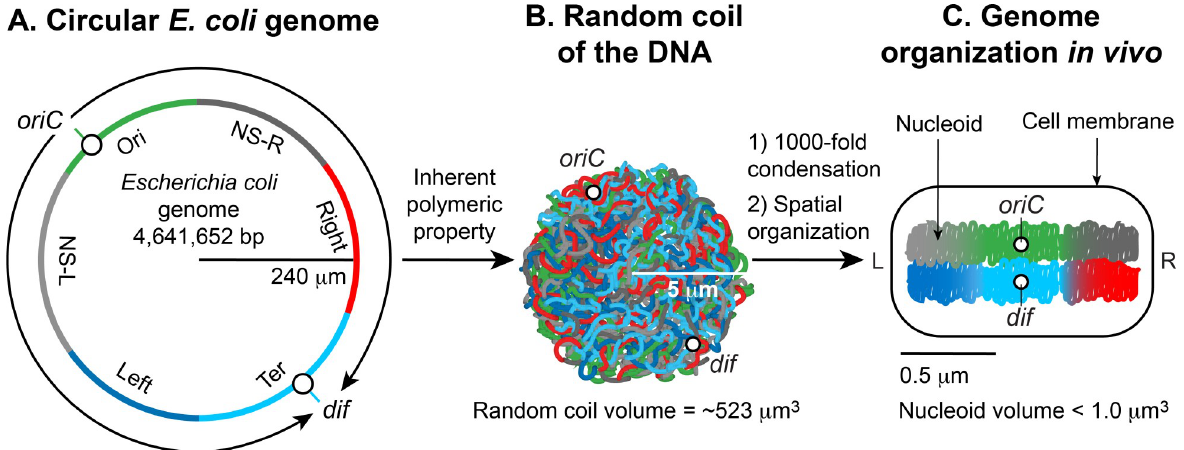
Fig 1. Formation of the Escherichia coli nucleoid. A. An illustration of an open conformation of the circular genome of E . coli . Arrows represent bi-directional DNA replication. The genetic position of the origin of bi-directional DNA replication ( oriC ) and the site of chromosome decatenation ( dif ) in the replication termination region ( ter ) are marked. Colors represent specific segments of DNA as discussed in C. B. An illustration of a random coil form adopted by the pure circular DNA of E . coli at thermal equilibrium without supercoils and additional stabilizing factors [5, 6]. C. A cartoon of the chromosome of a newly born E . coli cell. The genomic DNA is not only condensed by 1000-fold compared to its pure random coil form but is also spatially organized. oriC and dif are localized in the mid-cell, and specific regions of the DNA indicated by colors in A organize into spatially distinct domains. Six spatial domains have been identified in E . coli . Four domains (Ori, Ter, Left, and Right) are structured and two (NS-right and NS-left) are non-structured (See section 4 of the main text for details). The condensed and organized form of the DNA together with its associated proteins and RNAs is called nucleoid. Drawings are not in scale with each other.